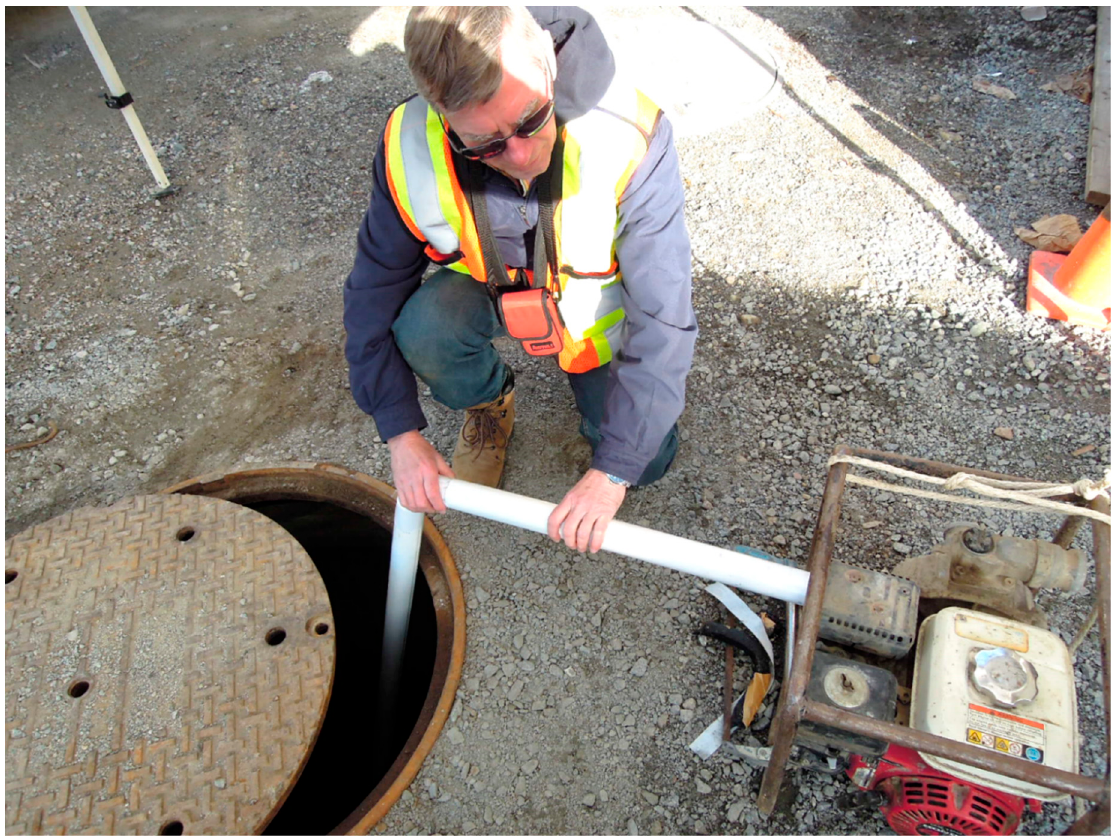
Figure 3. Injection into the airspace of exhaust gas from the exhaust port of the engine. The tube directed flow to the bottom of the space commencing immediately after starting the engine (choke closed immediately afterward). Closure of the manhole cover occurred immediately after injection of exhaust gas for a period of 15 min of calming and equilibration to the conditions created in the space by enclosure.